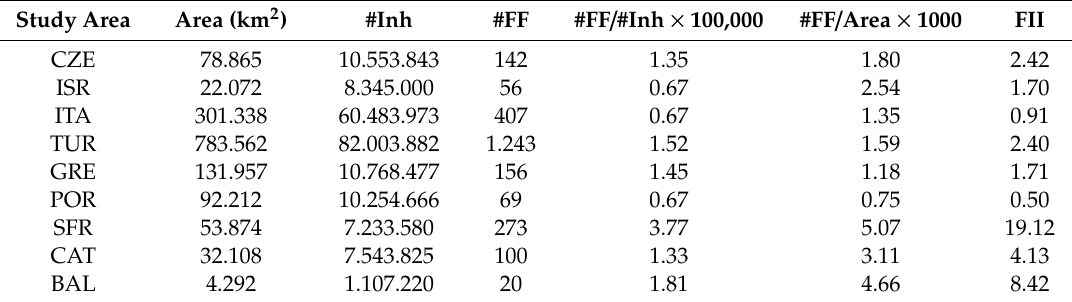
Table 4. Flood Impact Index (FII).